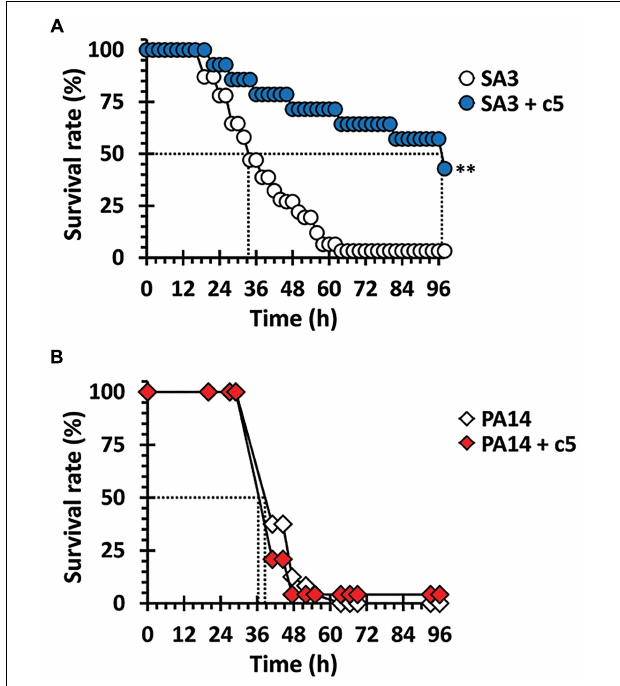
FIGURE 3 | Antibacterial efficacy in vivo . Mortality of infected flies fed with c5 was measured. Infected flies with SA3 (A) and PA14 (B) were transferred to a new medium overlaid with 1 mg/ml of c5 (filled) or without treatment (open). The dotted lines represent the time required to reach 50% mortality. The statistical significance based on a log-rank test is indicated as follows: ∗∗ , p <